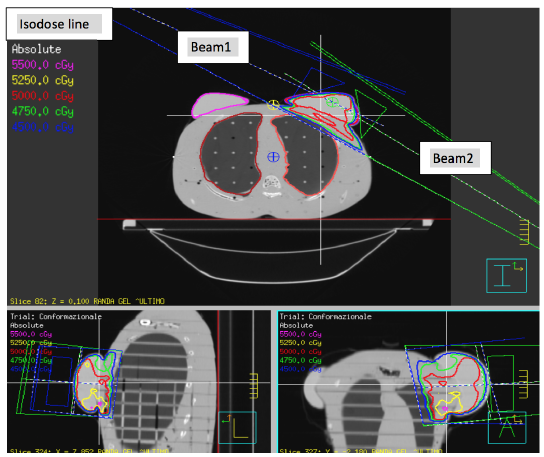
Figure 3. A screenshot of reference treatment plan dose distribution for 50 Gy dose prescription. Isodose lines are displayed in sagittal, coronal and axial views.